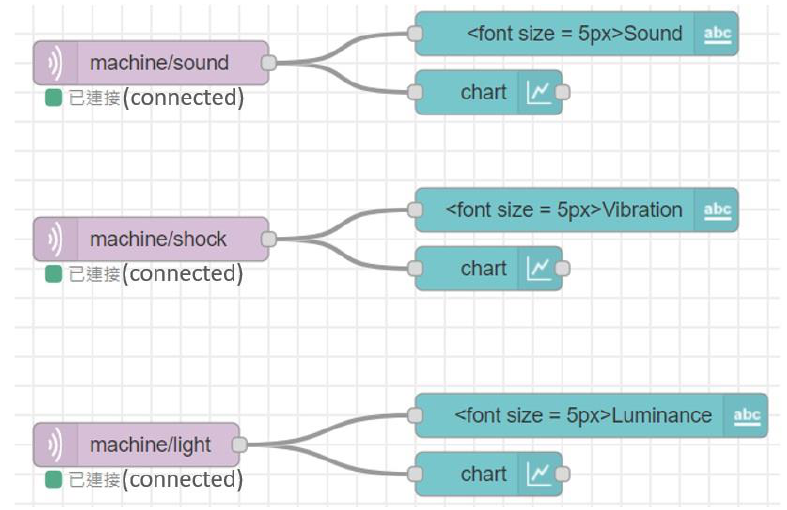
Figure 6. Part of the Node-RED flow of the implemented system.